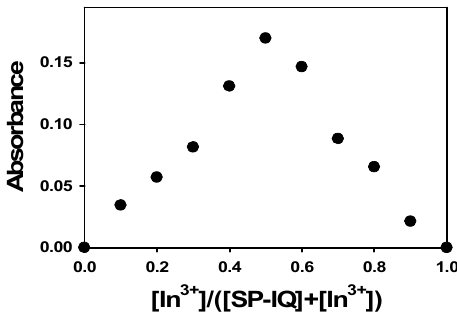
Figure 10. Job plot of SP-IQ and In 3+ cation. Absorbance at 410 nm for the mixed solutions of SP-IQ and In 3+ cation after being placed in the dark for 7 h was a function of the plotted as molar ratio [In 3+ ]/([ SP-IQ ]+[In 3+ ]). The total concentration for the mixed solutions of SP-IQ and In 3+ cation was 1 × 10 − 5 M.